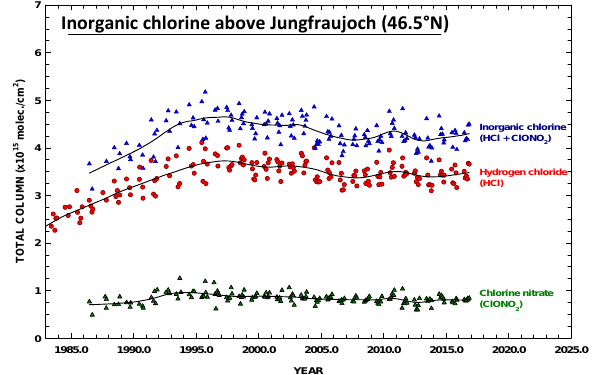
Figure 10. Inorganic chlorine above Jungfraujoch. Multi-decadal monthly mean total column time series of the two main chlorine reservoirs (hydrogen chloride (HCl; red circles) and chlorine ni- trate (ClONO 2 ; green triangles)), monitored at the Jungfraujoch station (Swiss Alps; 46.5 ◦ N; 3580ma.s.l.) in the framework of the NDACC network. The data sets are restricted to the June to November months so as to limit the impact of variability caused by atmospheric transport and subsidence mainly during winter to springtime. A good proxy of northern midlatitude total inorganic chlorine (Cly) is obtained by summing the HCl and ClONO 2 to- tal columns (see blue triangles). The thin continuous lines cor- respond to non-parametric least-square fits involving an integra- tion time of about 3 years; they help appraise a non-monotonous decrease in chlorine in the stratosphere after 1996–1997. Using the 1997.0 Cly column as reference and the bootstrap resampling tool of Gardiner et al. (2008), a mean post-peak rate of change of − (0.50 ± 0.15)%yr − 1 is obtained for the 1997–2016 time period. Courtesy: Emmanuel Mahieu et al., Univ.